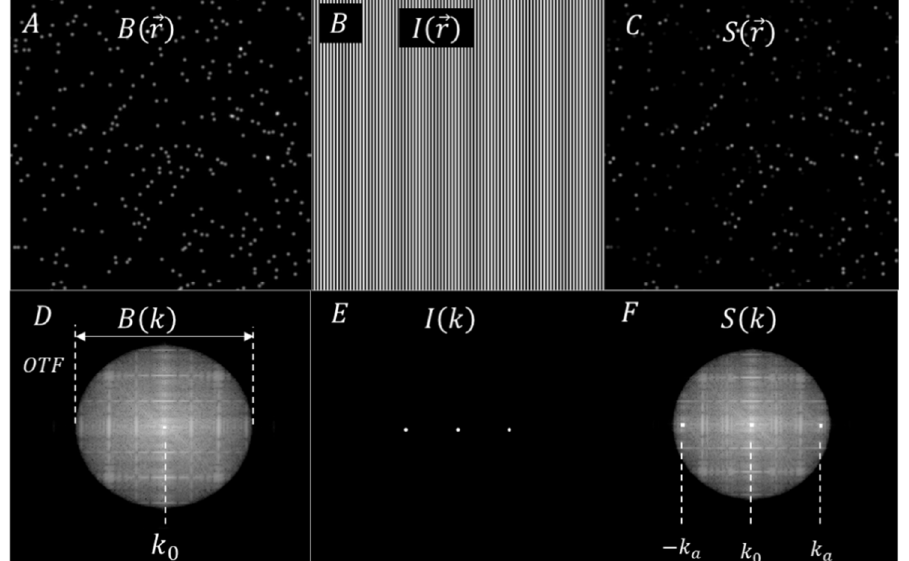
Figure 2. Frequency shift produced by sinusoidal structured illumination for SIM. Sample ( A ) is illuminated with the SIM pattern ( B ); then, an emission ( C ) enters the microscope system and is blurred by the PSF. ( D – F ) show the corresponding transformation of ( A – C ) in frequency space. ( D ) The low-frequency information 𝑘 (cid:2868) of the sample is within the passband of the optical transfer func- tion (OTF) and is detectable. ( E ) The Fourier transform of the sinusoidal illumination pattern con- sists of high-frequency information. ( F ) When the sample is illuminated with a periodic fringe pat- tern ( (cid:3399)𝑘(cid:4652)⃗ (cid:3028) ), some high-frequency information is contained in the OTF passband.